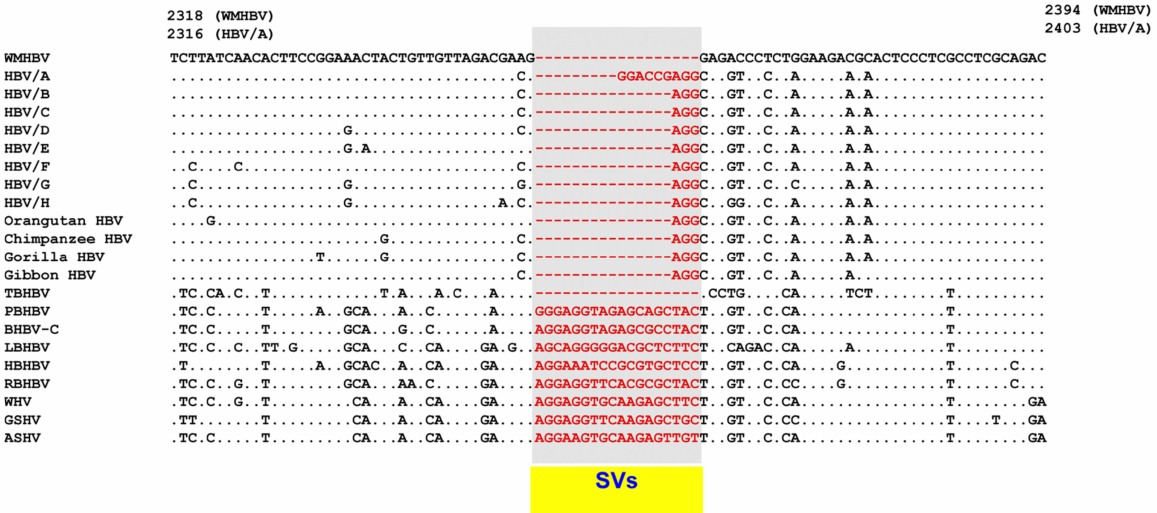
Figure 3. Alignment of the core ORF from nt 2318 to 2394 (WMHBV) showed different SVs in HBV/A and species of orthohepadnaviruses in this region. The polymorphic SVs change the length of amino acid residues in N-terminal helices of HBV polymerase terminal protein. Reproduced from reference 69, and modified. Details of the consensus genome sequences of human HBV and the non-human primate, bat and rodent HBV strains are provided in the legend to Figure 2. Genetic sequences of the strains are available in Reference